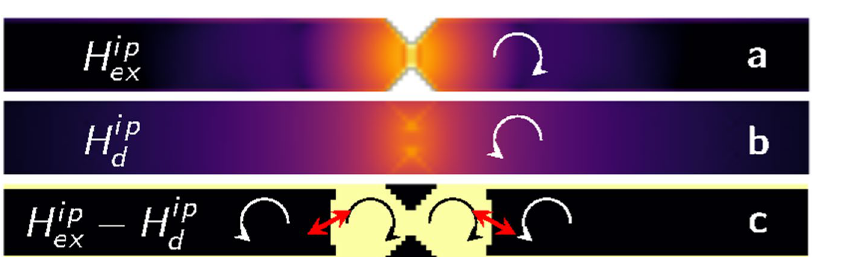
Figure 8. Competition between the in-plane components of exchange and dipolar field is the origin of SW excitation. The intensity of the in-plane component of the exchange field ( a ) and the dipolar field ( b ) for a DW placed at the center of the wire at rest is plotted in dark to bright colour scale. The arrow indicates the direction of rotation of the in-plane component of the field when the DW is led to rotation via an applied current. c The sign of − H H exip dip marked as bright (dark) for positive (negative). Arrows indicate the direction of rotation of the combined in-plane